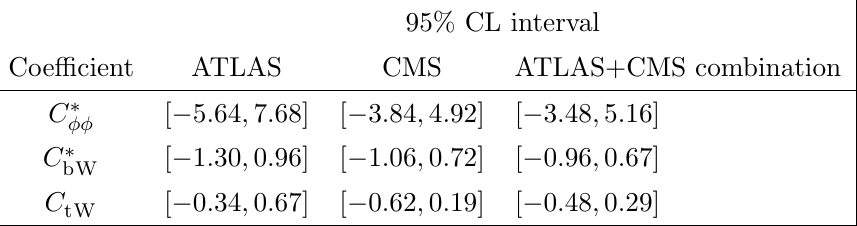
Table 9 . Allowed ranges for the Wilson coe(cid:14)cients C (cid:3) each coe(cid:14)cient is obtained while (cid:12)xing all other coe(cid:14)cients to their SM values. The limits from CMS are obtained using the pre-combined result of all CMS input measurements. The numerical values are obtained by setting the (cid:3) scale to 1 TeV, and the coe(cid:14)cients are assumed to be